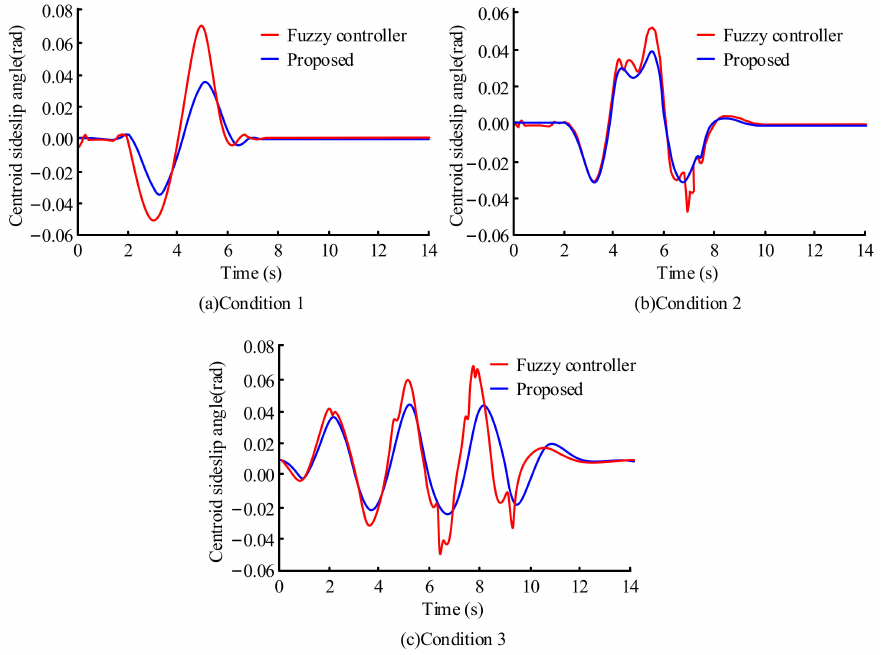
Figure 4. Simulation results of centroid sideslip angle.